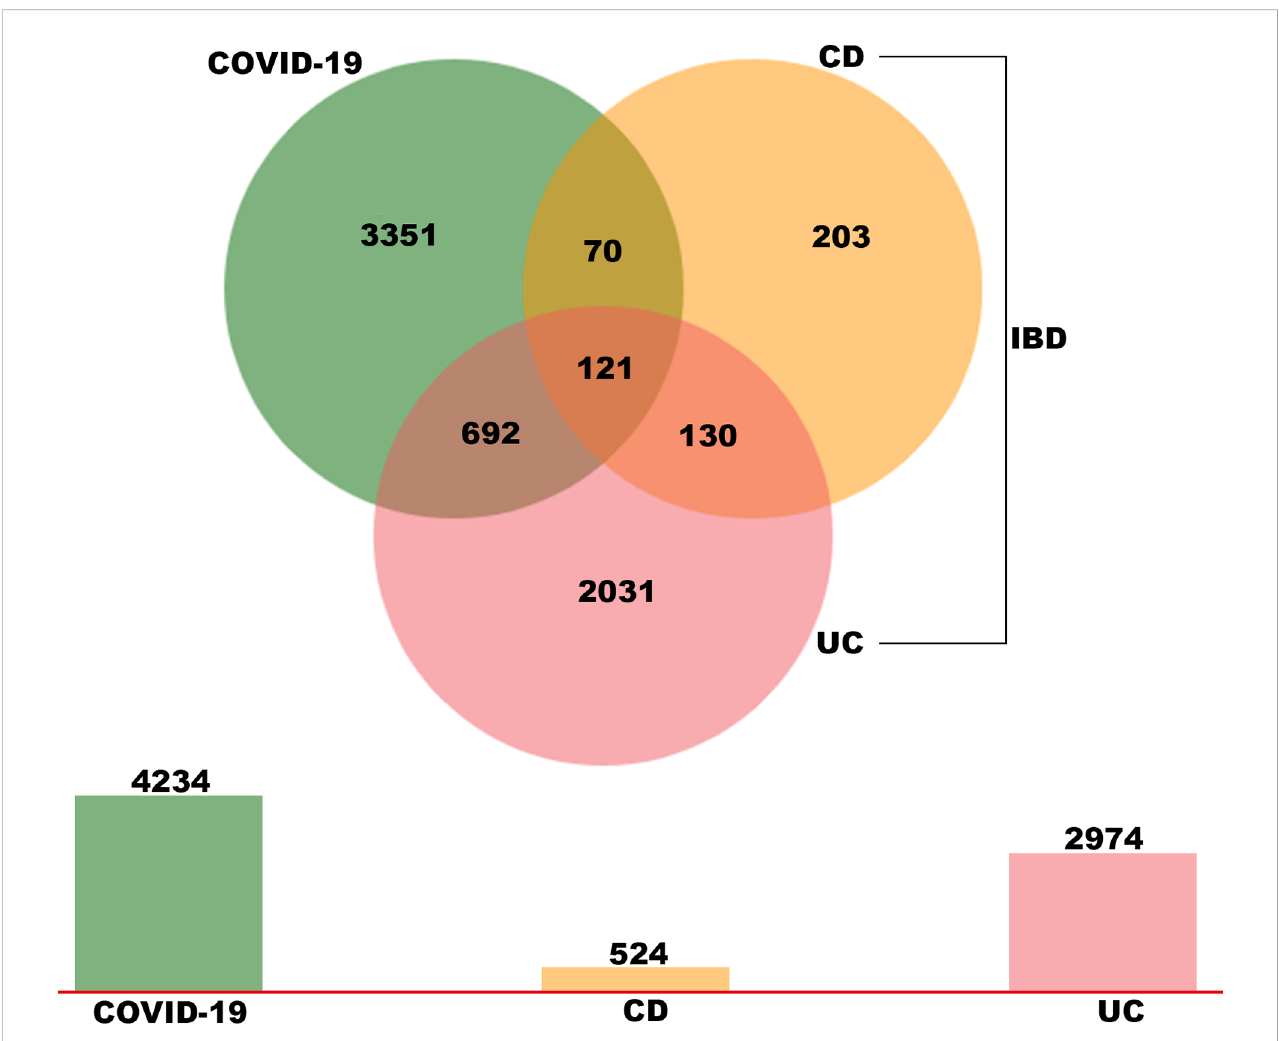
FIGURE 2 Identi fi cation of common DEGs between COVID-19, UC and CD via a Venn diagram. This study incorporates four RNA-sea datasets comprising of COVID-19 (GSE147507), UC (GSE 9686 and GSE 36807) and CD (GSE 126124). A total of 121 common DEGs were identi fi ed among COVID-19, UC and CD by integrated